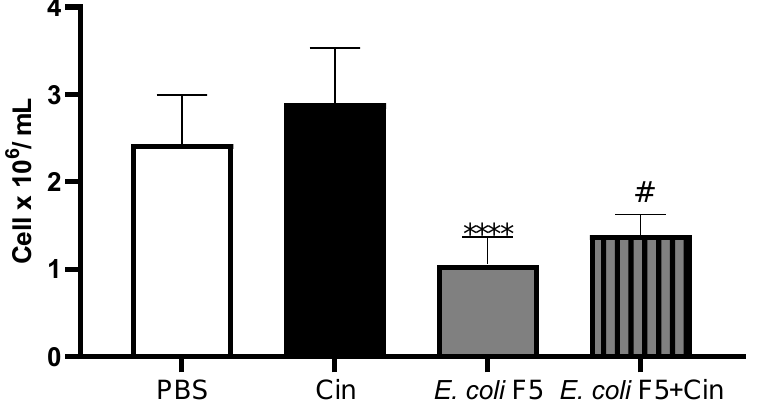
Figure 5. Peritoneal cell counts of animals infected with E. coli F5 and cinnamaldehyde treatment. Ten hours after peritoneal inoculation of E. coli F5, the peritoneal cells of the mice were collected from the lavage of the peritoneal cavity. The cells were stained with 0.05% violet crystal in 30% acetic acid and counted under a light microscope. The results represent the mean ± S.D. of 6 animals/group. **** p < 0.0001 as compared with the CIN group and # p < 0.05 as compared with the E. coli F5 group